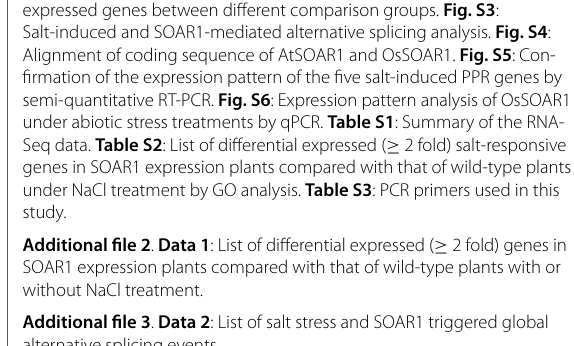
2 fold) salt‑responsive ≥ 2 fold) genes in ≥